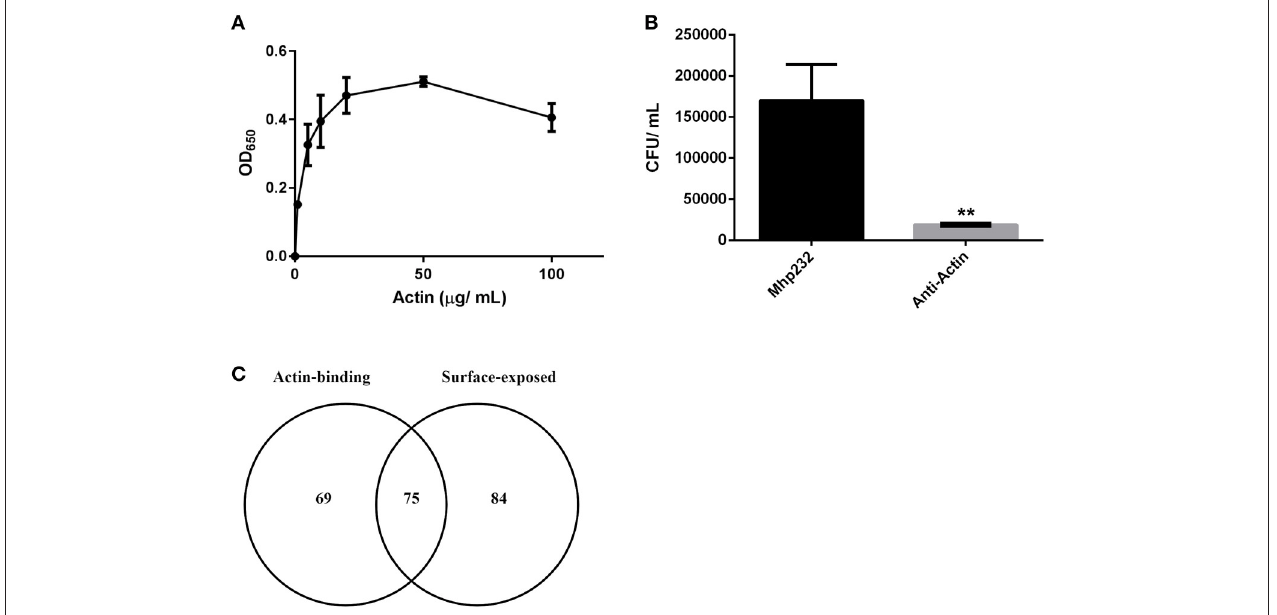
FIGURE 4 | M. hyopneumoniae binds actin. (A) Microtiter plate binding assay of immobilized M. hyopneumoniae cells binding to actin in a dose-dependent and saturable manner. Each data point represents the average of individual triplicate experiments with the standard error of the mean shown. (B) Treatment of PK-15 cell monolayers with mAbs that target actin inhibited adherence of M. hyopneumoniae by ∼ 90%. The data is presented as the average of triplicate experiments and the standard error of the mean. An unpaired t -test was performed with a p < 0.01, indicated as **. (C) Venn diagram showing the overlap between putative actin-binding proteins purified using actin affinity chromatography, and M. hyopneumoniae surface